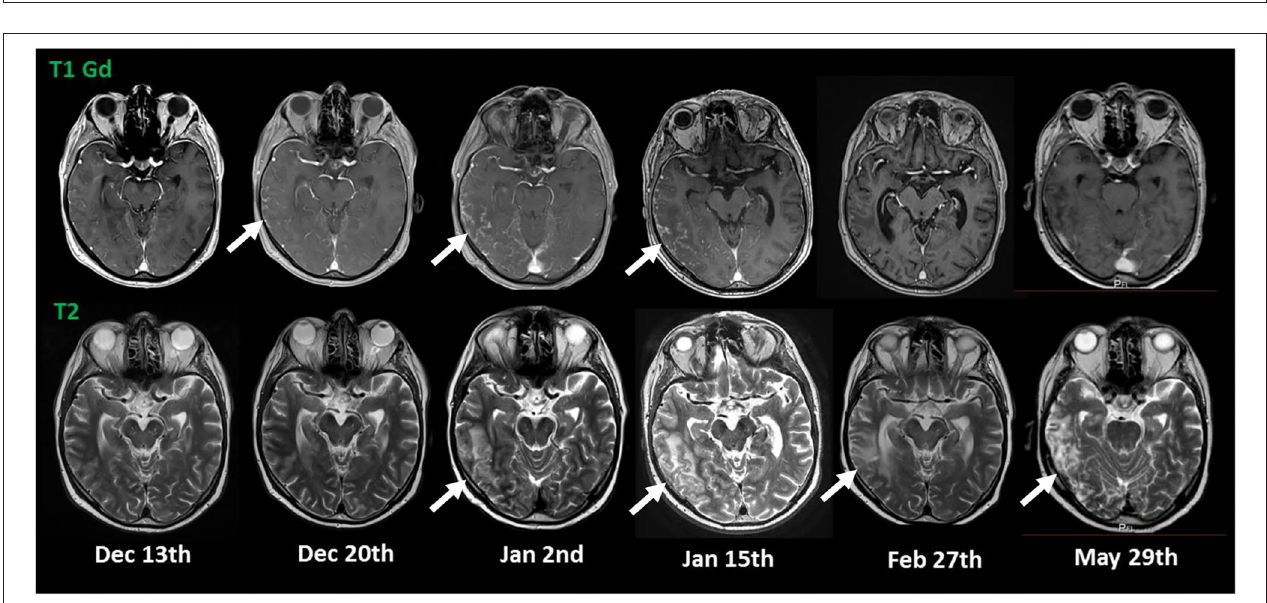
FIGURE 2 | MRI imaging. The initial MRI showed nodular, T1 contrast-enhancing lesions in the right temporo-parietal lobe (indicated by arrows in the upper row) suspicious for sarcoidosis with accompanying edema in T2 (indicated by arrows in the lower row). Discontinuation of dupilumab (Jan 8th) and initiation of a treatment with steroids (Jan 27th) led to quick regression of the nodular lesions and gradual regression of the brain edema.